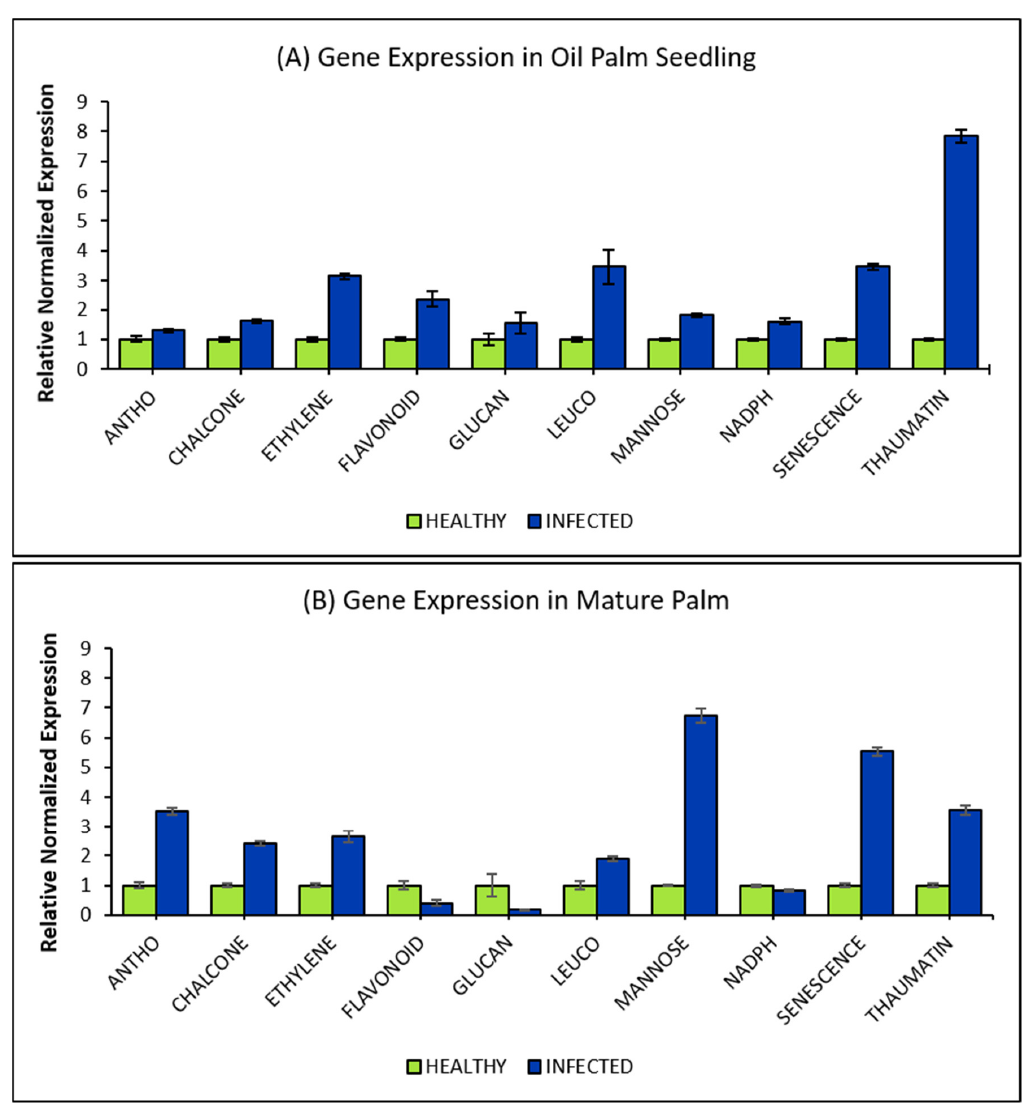
Figure 4. Mean of normalized expression fold for root target genes between G. boninense- infected tissues compared to healthy tissues. ( A ) Expression profile of root genes in nursery samples after normalization with GRAS and ACTIN reference genes and ( B ) expression profile of root genes in plantation samples after normalization with GAPDH and GvHK reference genes. The relative expression fold between two conditions being compared for both root samples was calculated by Bio-Rad C.F.X. Manager V3.0 software according to Vandesompele et al. [31].